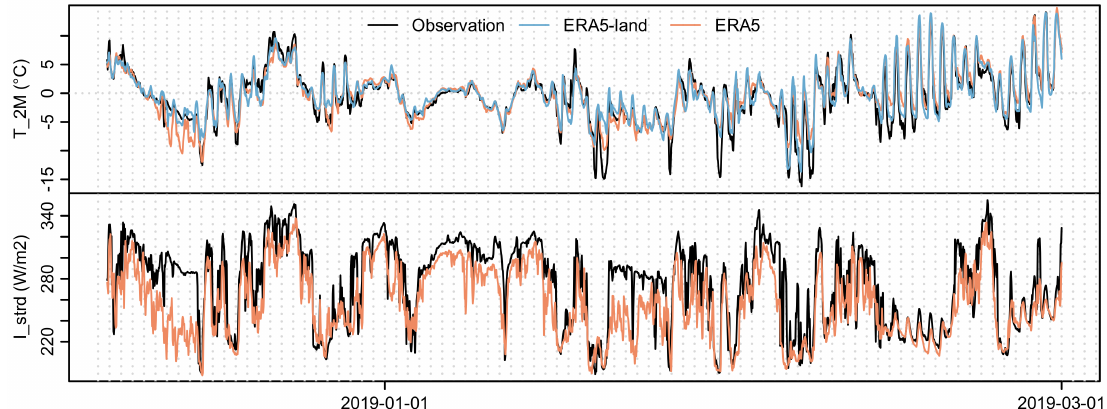
Figure 8. Observed outdoor temperature and longwave sky radiation at the Holzkirchen site compared to the ERA5 reanalysis for the period 7 December 2018 to 28 February